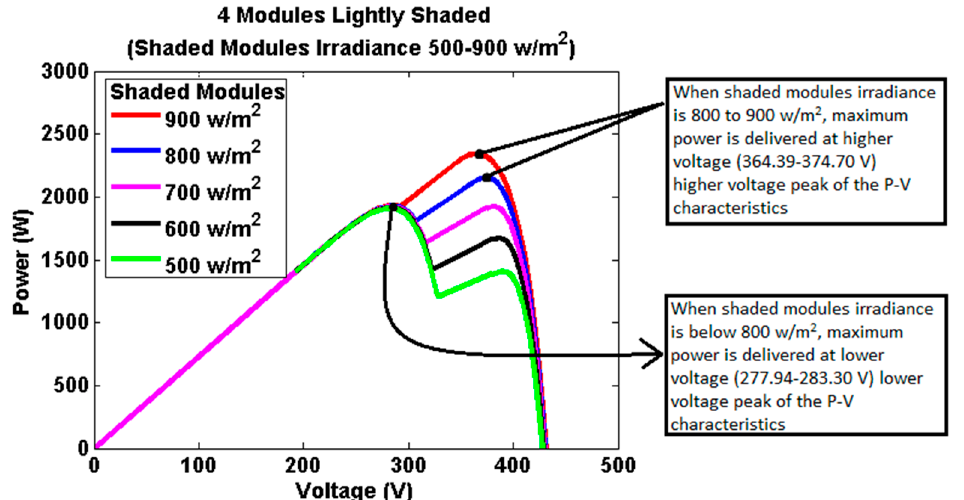
Figure 21. Delivery voltages for maximum power (4 modules shaded setup).